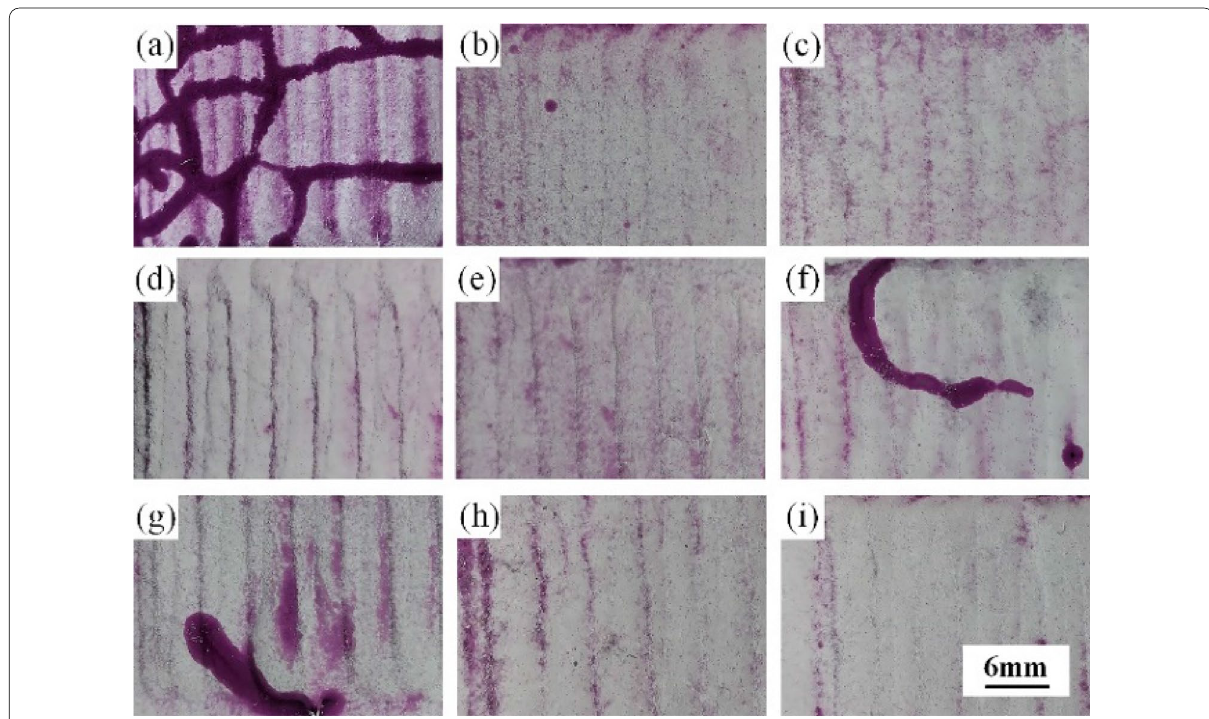
Figure 4 Crack observation by dye penetrant test: ( a ) Ni60, ( b ) Ni60 coating Ni60